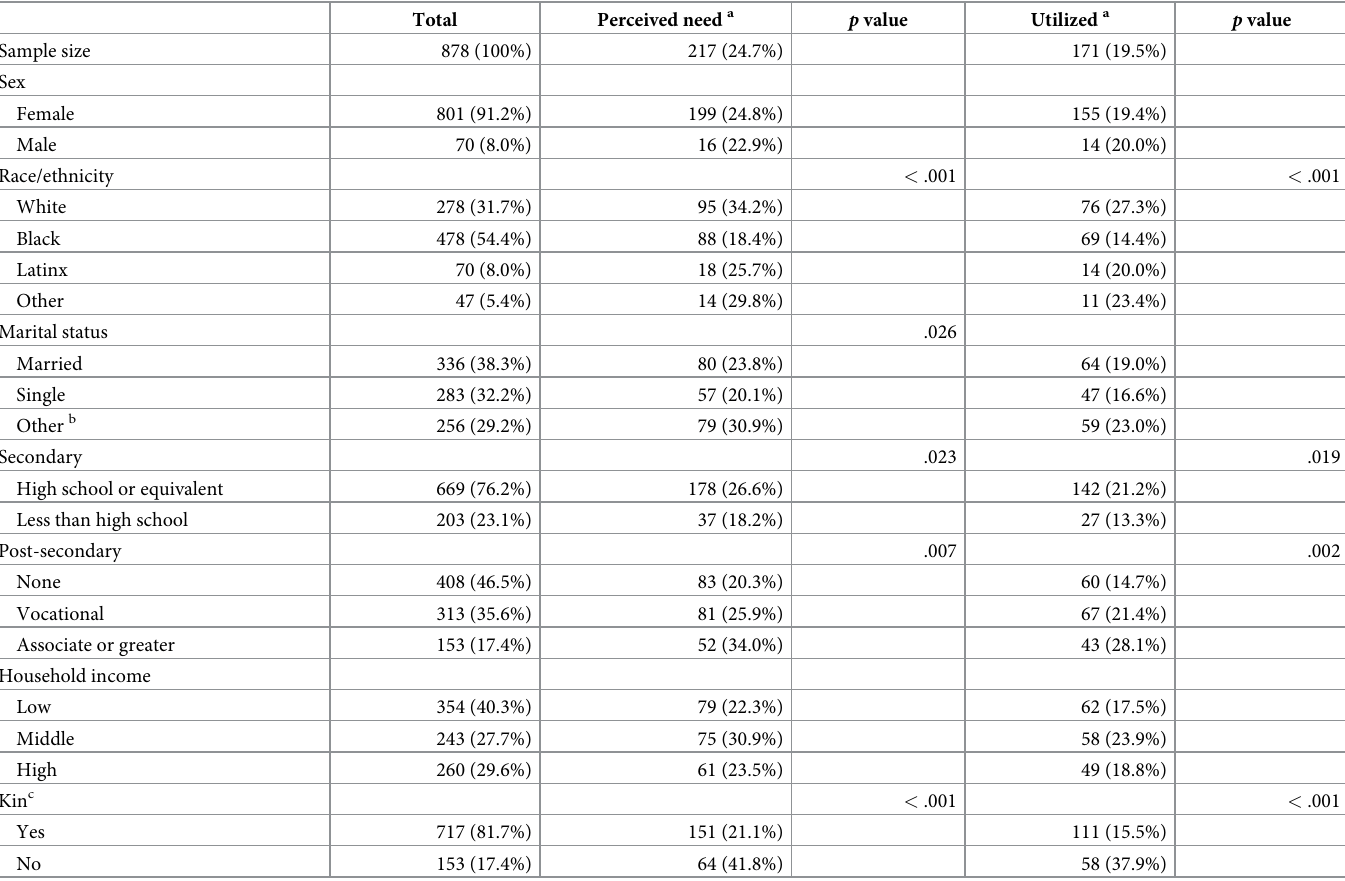
Table 1. Caregiver demographics at age 16 interview by counseling